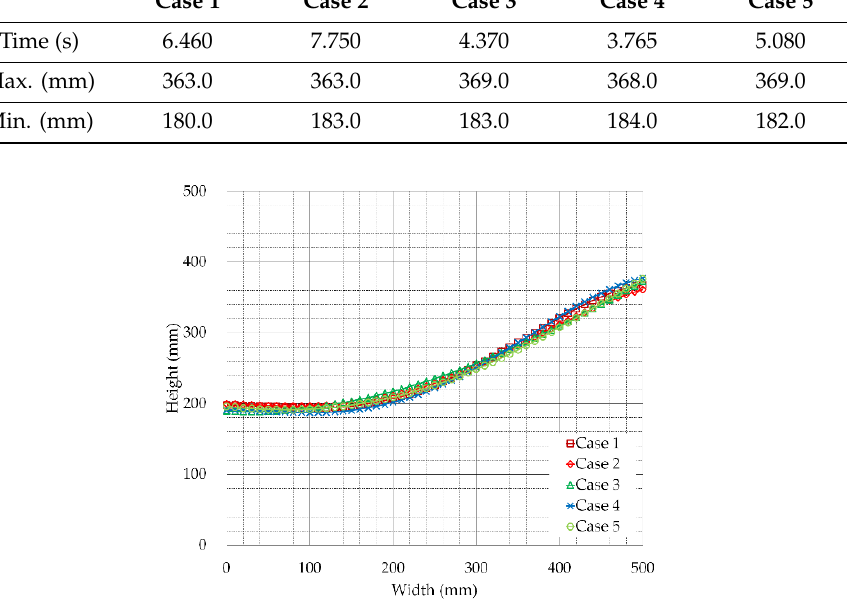
Figure 8. Comparison of fluid surface shape by earthquakes of different shapes.